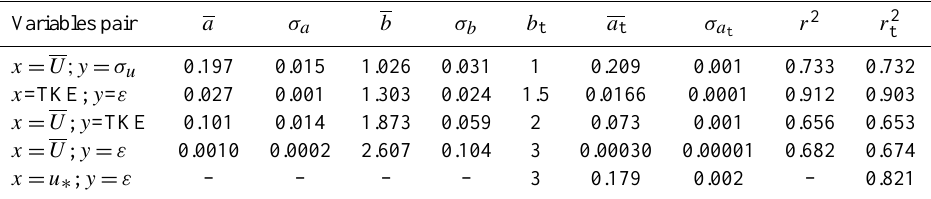
Table 1. Results of the fitting procedure. Each row contains fitting coefficients for a certain pair of variables addressed in the first column. These variables are evaluated over the 4 day bora episode. Given are the mean values and standard deviations of the a priori unknown coefficients a and b from the relation (4b), and the coefficient a t from the relation (4c), where b t is the a priori known theoretical coefficient. Also, the corresponding correlation coefficients squared r 2 and r 2 t are